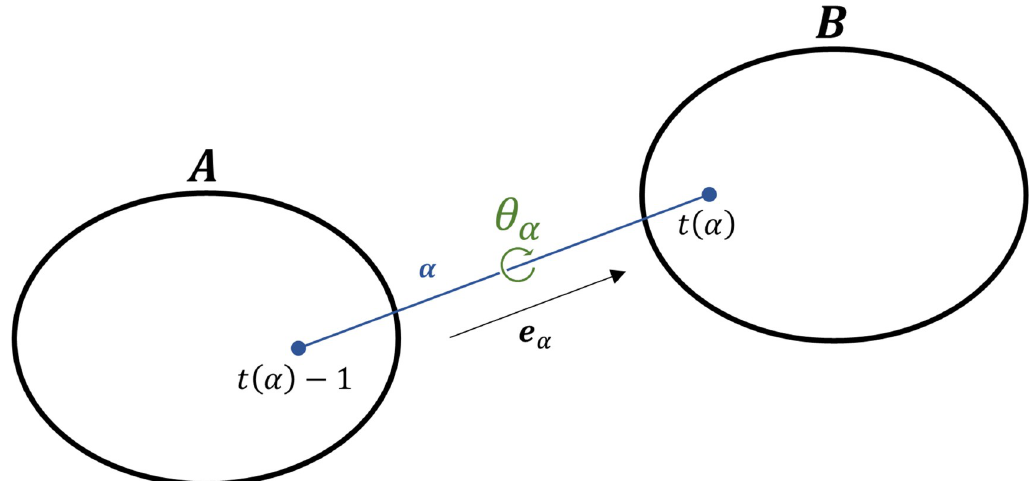
Fig 1. Schematic of a molecular system composed of two rigid bodies A and B with a chemical bond α . The relative displacement between the two bodies can be defined by the torsion angle θ α around the bond α . If a bond α links atoms ( i − 1) to i , t ( α ) designates i